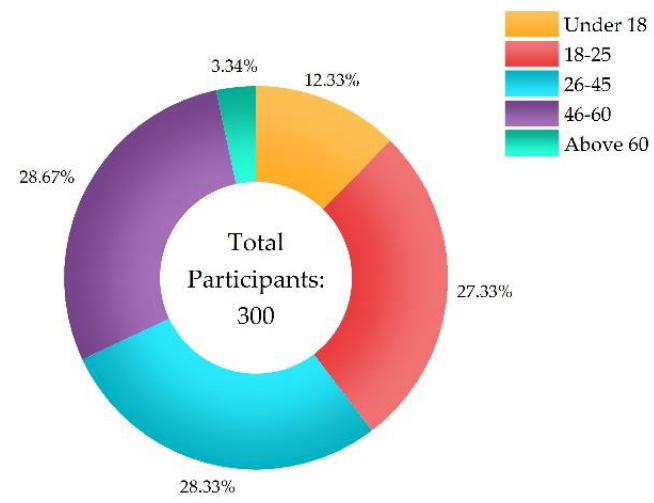
Figure 4. Age of Figure 4. Age of participants.